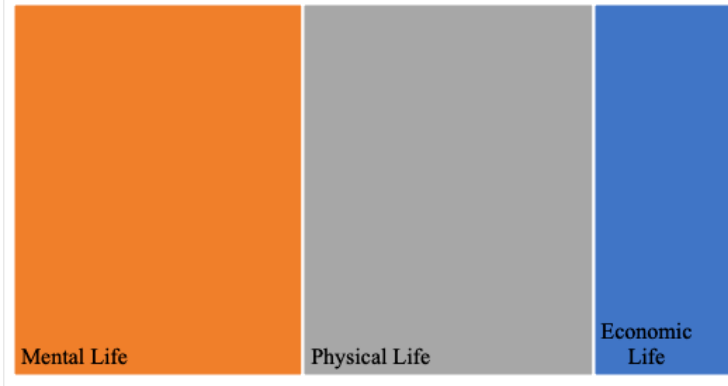
Figure 4. Impacts on the life of